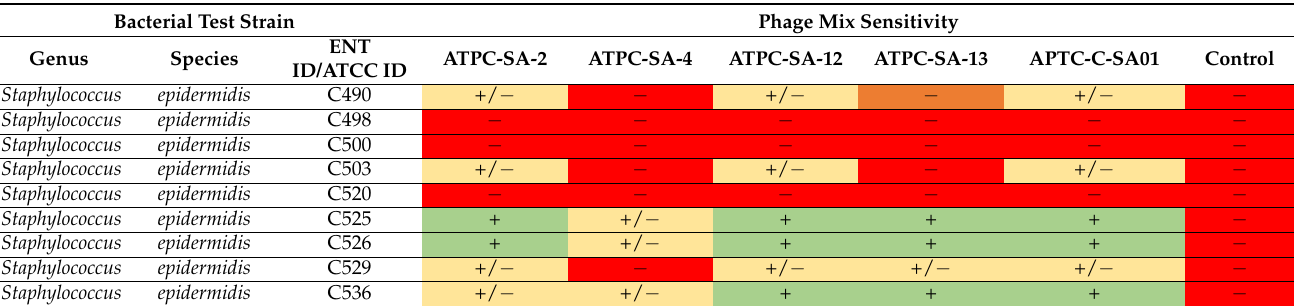
Table 4. S. aureus phage and the cocktail against non-target bacterial